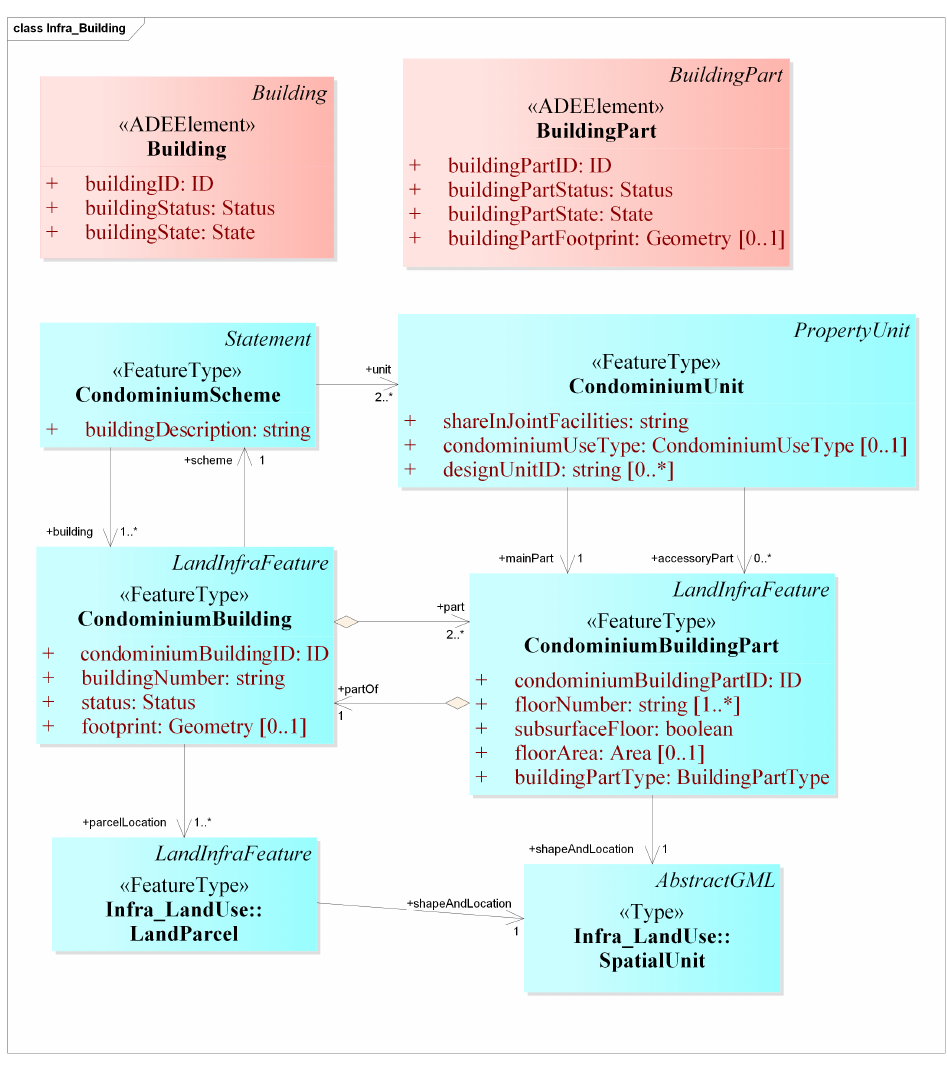
Figure A8. The UML excerpt depicts the CityGML CG::Building and CG::BuildingPart extended to include the attributes from the LandInfra LI::FacilityPart . It also shows